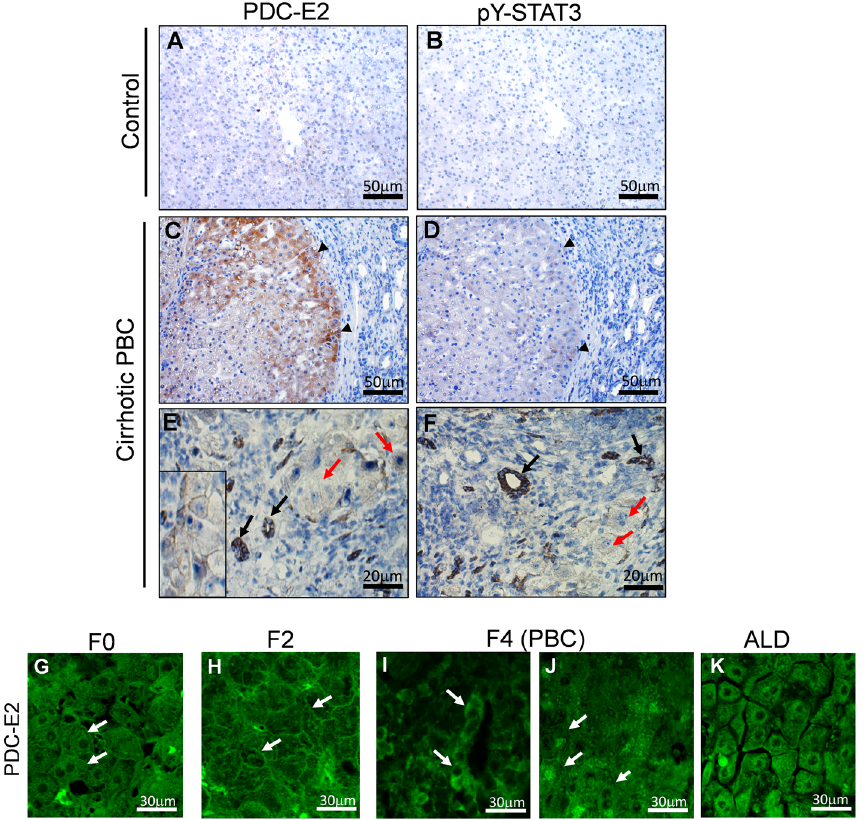
Figure 5. Localization of PDC-E2 and p-STAT3 in cirrhotic (PBC or ALD) and control liver tissues. Immunohistochemical analysis shows that in cirrhotic/PBC tissues, PDC-E2 ( C ) and pY-STAT3 ( D ) are present mainly on the edge of regenerating nodules in contrast to control tissues, in which both examined proteins are barely visible ( A and B ). Additionally, in PBC tissues PDC-E2 and pY-STAT3 are present in both cholangiocytes ( E and F , red arrows) and hepatocytes ( E and F , black arrows). Scale bar—50 and 20 µm. A representative immunofluorescent staining of PDC-E2 at different stages of PBC development ( G – J ) and of ALD tissues ( K ) are shown. Membrane localization of PDC-E2 is pointed by white arrows. Scale bar is 30 µm. Objective magnification ×20, zoom 3.